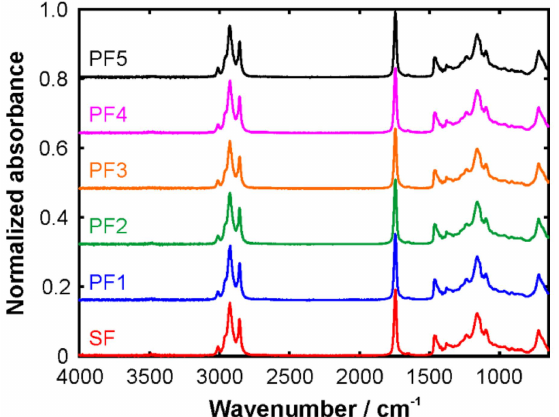
Figure 1. FTIR spectra of the di ff erent oil samples. PF indicates the passion fruit oils and SF marks the sunflower